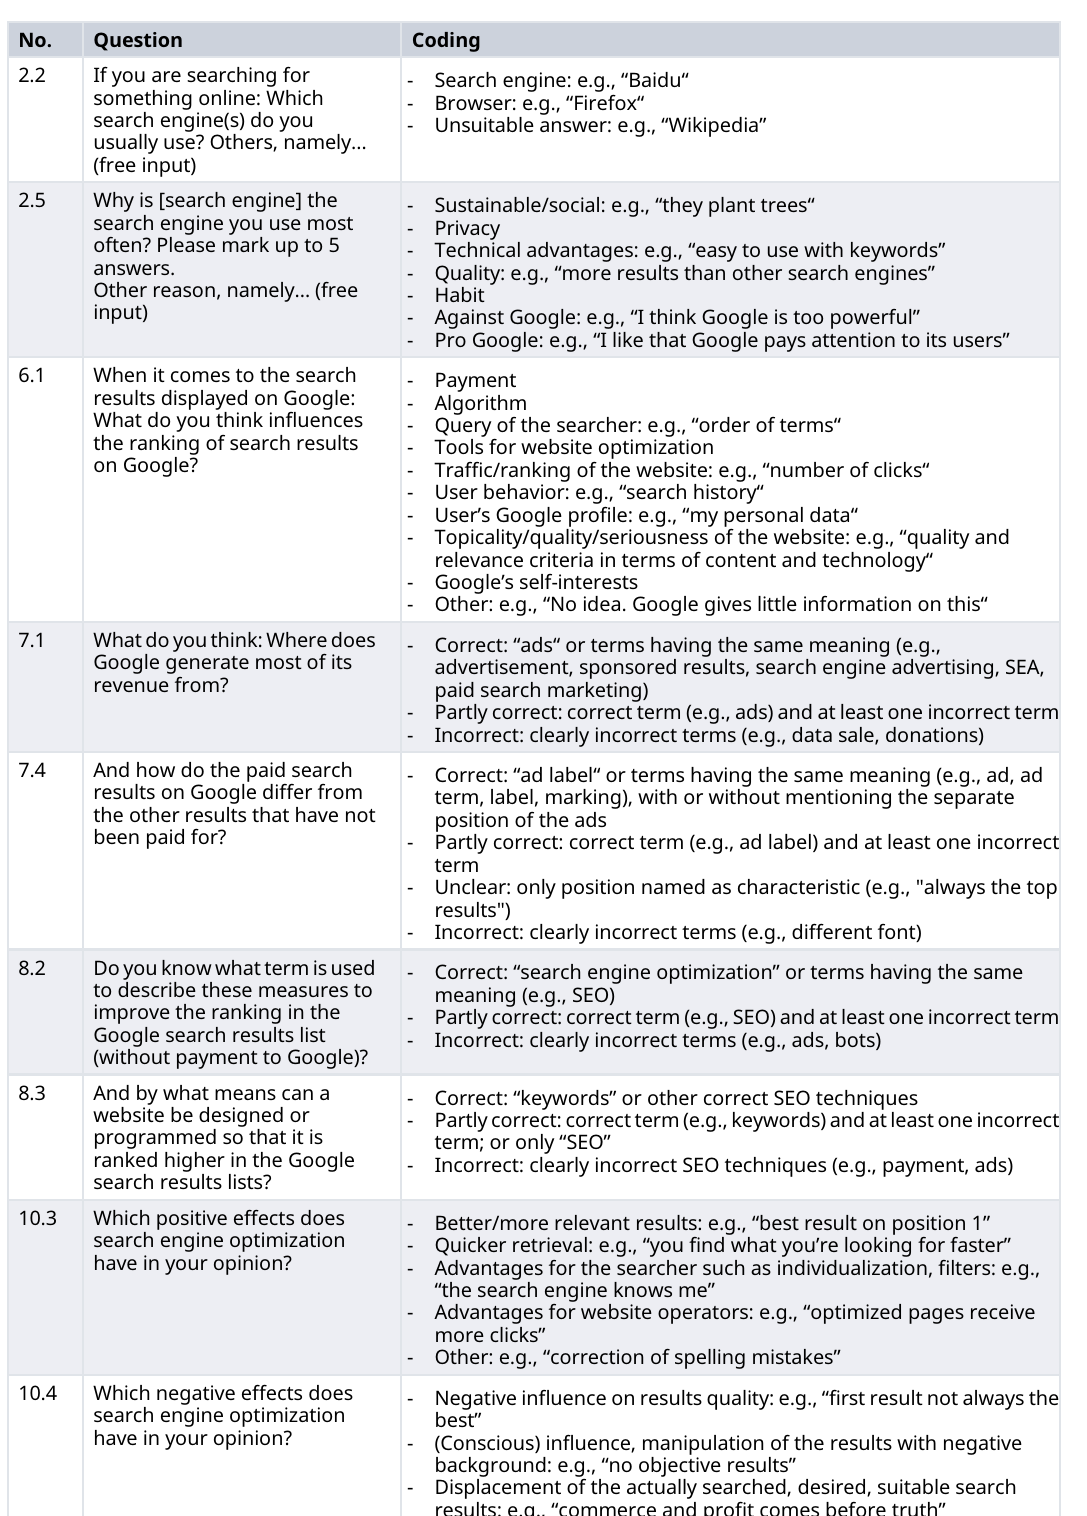
Table 3. Coding of open-ended